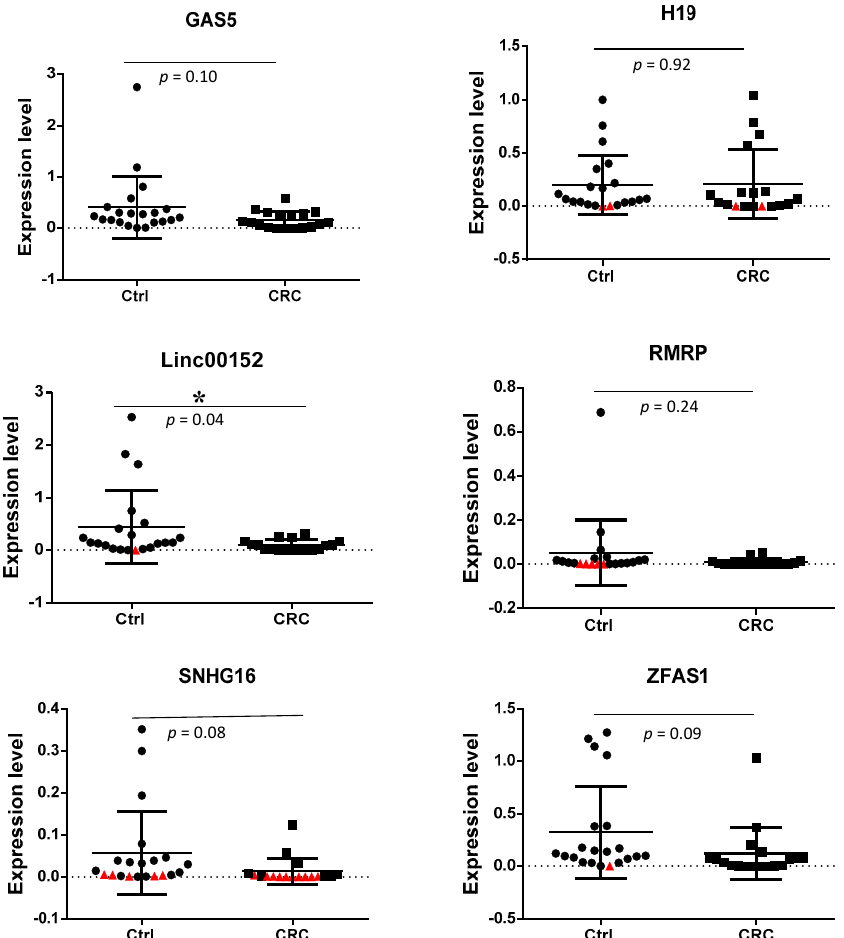
Figure 2. Comparison of lncRNAs expression level (2 ( − ∆ Ct) ) in serum exosomes from CRC and non-cancer individuals (Ctrl). The levels of lncRNA expression have been normalized to the reference gene, B 2 M. The student’s t -test was used to compare the expression of six lncRNAs between non- cancer individuals and CRC patients, * indicates p < 0.05. Samples with Ct value above the cut-off value of 30 were considered as negative expression. Samples that could not be amplified were plotted as red triangles.